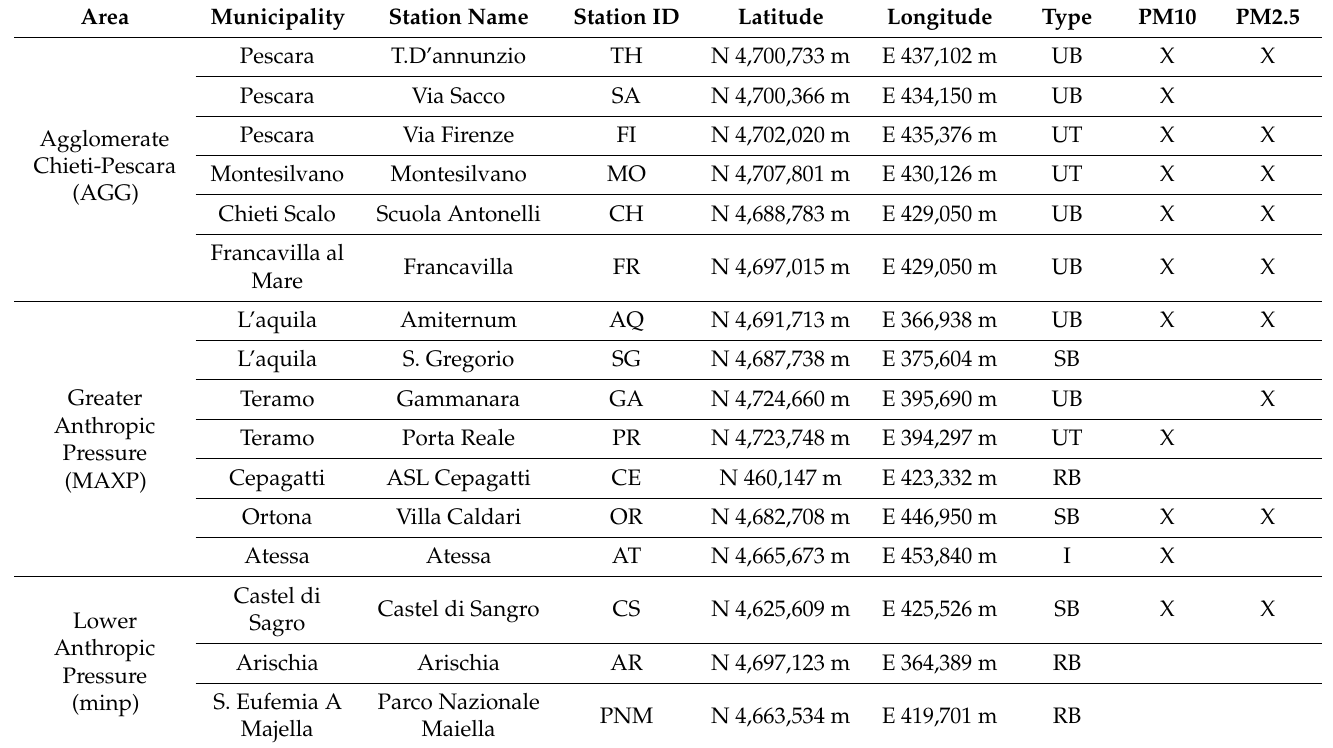
Table 1. Summary table of the fixed stations of the Abruzzo regional network for monitoring air quality, with details of the measured